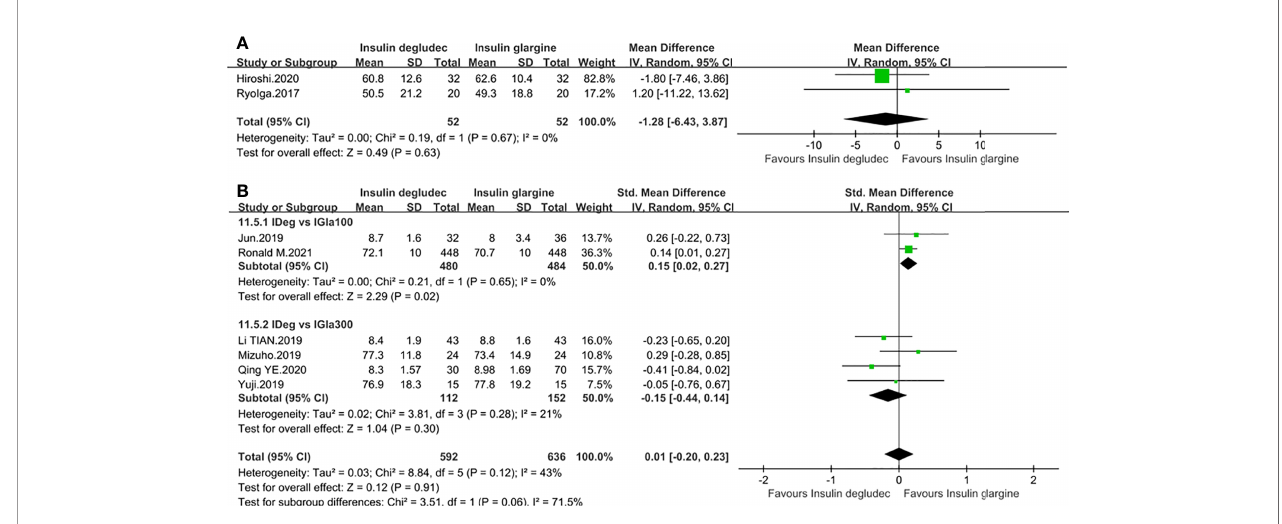
FIGURE 6 | Forest plot for the TIR. (A) TIR in patients with type 1 diabetes; (B) TIR in patients with type 2 diabetes according to the type of